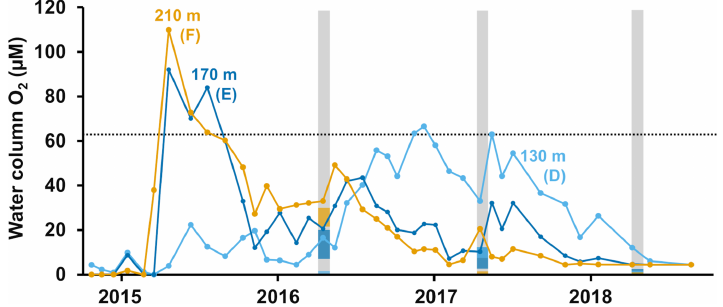
Figure A1. Oxygen monitoring data. Water column oxygen concentrations at depths corresponding to stations D–F at the SMHI (Swedish Meteorological and Hydrological Institute) monitoring station BY15 (SMHI, 2021). The grey lines indicate when samplings for this study were conducted; the dotted line shows the limit for hypoxia (63µM). Colours on the lines show the bottom water concentration measured by the benthic chamber lander at each station. Following van de Velde et al. (2020b).